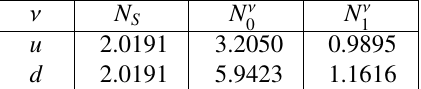
which appears in Table 1 and 2, corresponding i